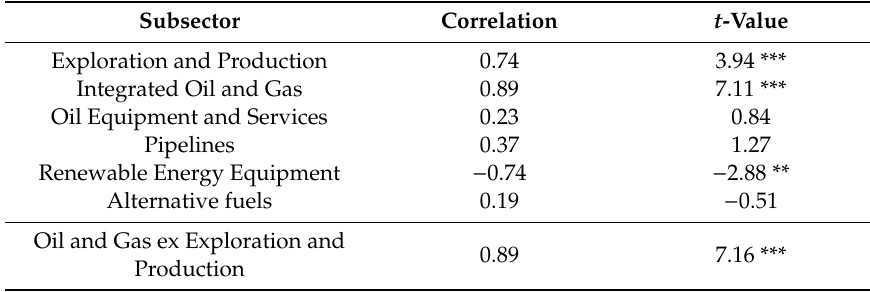
Table A4. Correlations between the GPCF and the operating cash flows of the respective subsectors of Oil and Gas. Each company’s cash flow weighted individually with the weights in the FTSE GAISAC index, scaled to correct for missing